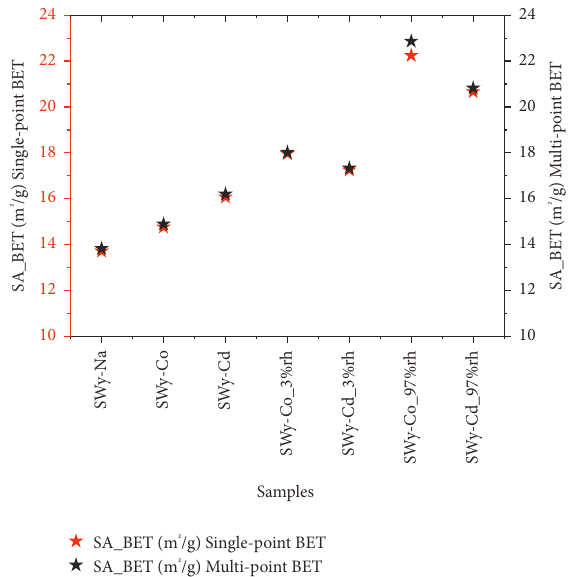
Figure 6: SA BET single and multipoint BET for unstressed and stressed